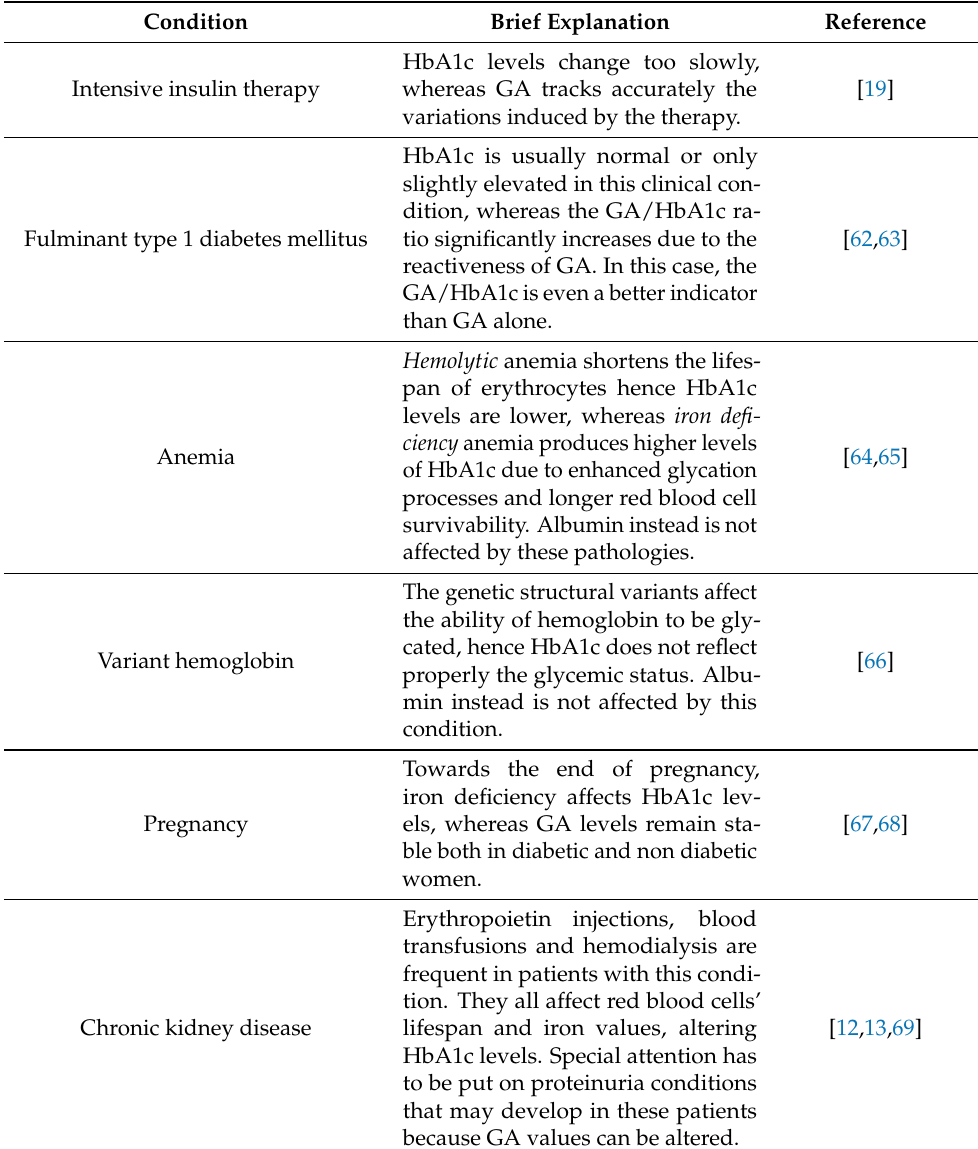
Table 2. List of conditions in which GA may be more reliable than HbA1c as a glycemic con- trol